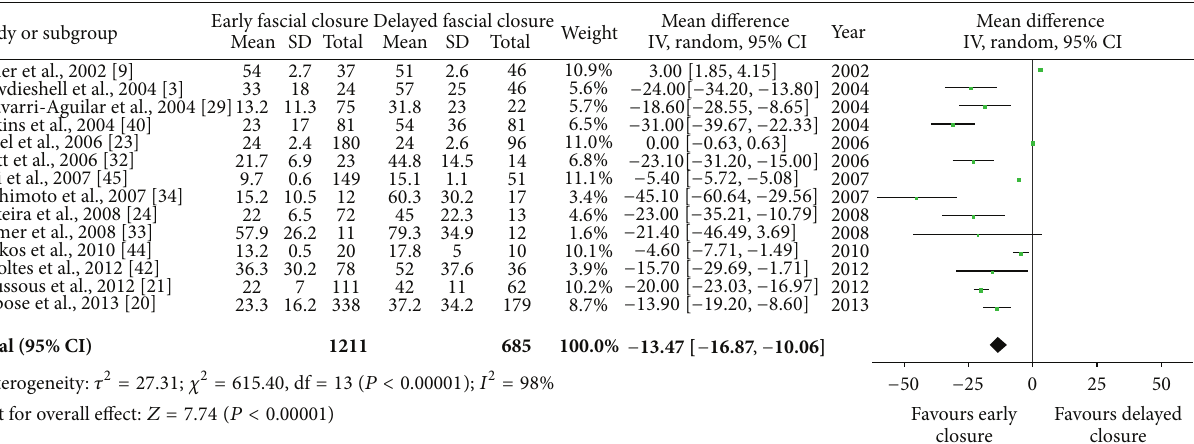
Figure 4: The mean length of total hospital stay for patients with early fascial closure or delayed closure. Estimated SD values in some trials were calculated from five percent of correlated mean